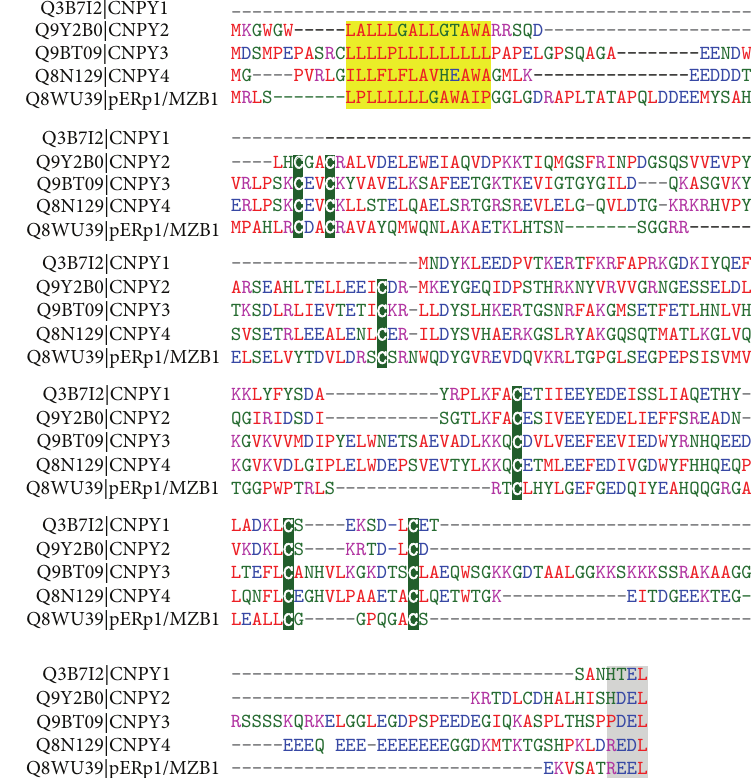
Figure 4: Alignment of pERp1/MZB1 and members of the CNPY protein family. The alignment of the five human protein sequences with UniProt identifiers as indicated was generated with the ClustalW algorithm and manually curated. The signal peptide encoding residues are highlighted in yellow, the C-terminal KDEL-like tetrapeptides are highlighted in grey, and the conserved cysteines in green. Standard color coding for the residues is as follows: alkaline in pink; acidic in blue; other hydrophilic in green; and hydrophobic in